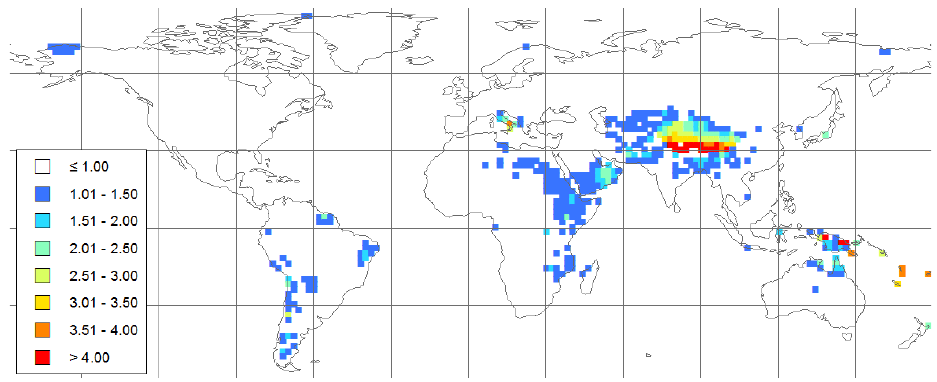
Fig. 11. The 95% CIs of model M4 for mean δ 2 H ANN in precipitation. The legend scale is ± δ 2 H expressed in ‰. The highest CIs (poorest Fig. 11. The 95 % CIs of Model M4 for mean δ 2 H in precipitation. The legend scale is ± δ 2 H performance) are clearly observed in the Himalayan region in Asia. See text for discussion. ANN expressed in ‰. The highest CIs (poorest performance) was clearly observed in the Himalayan region in Asia. See text for discussion.